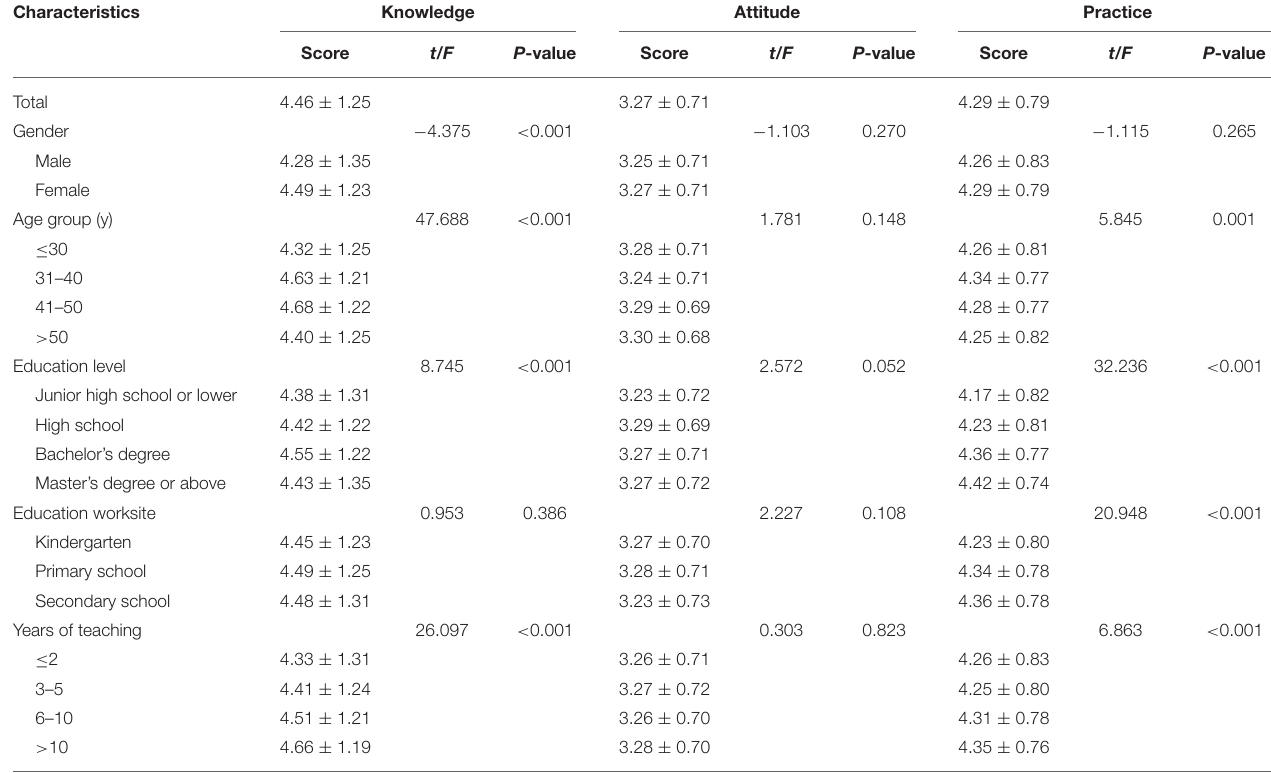
TABLE 2 | Knowledge, attitude, and practice scores of COVID-19 by demographic variables.